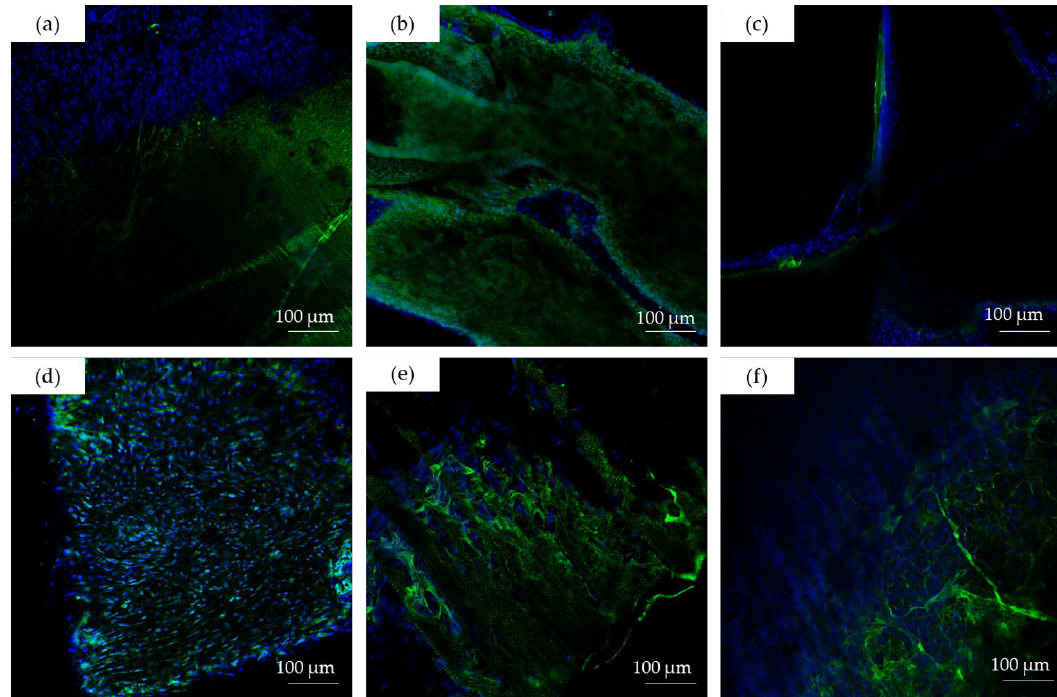
Figure 8. CLSM images (×20) of: ( a ) brain; ( b ) intestine; ( c ) skin; ( d ) blood vessels; ( e ) cornea; and ( f ) gonad cells on hydrogel surfaces after organotypic culture. Cell nuclei (blue) were labeled using Hoechst 33,342 (blue), and the fibrin network (green) was stained using an FITC conjugated to anti-fibrinogen antibody.